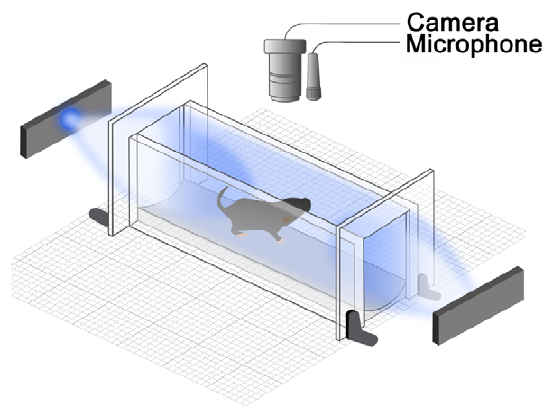
Figure 1. Schematic diagram of testing chamber. Mouse pups (P7–P9) were placed in a clear plastic enclosure with a blue LED positioned 5 cm from each end of the chamber. The pup’s behavior was monitored using an infrared camera to record motor responses and a broadband microphone to detect 62-kHz ultrasonic vocalizations (USVs) and 5-kHz